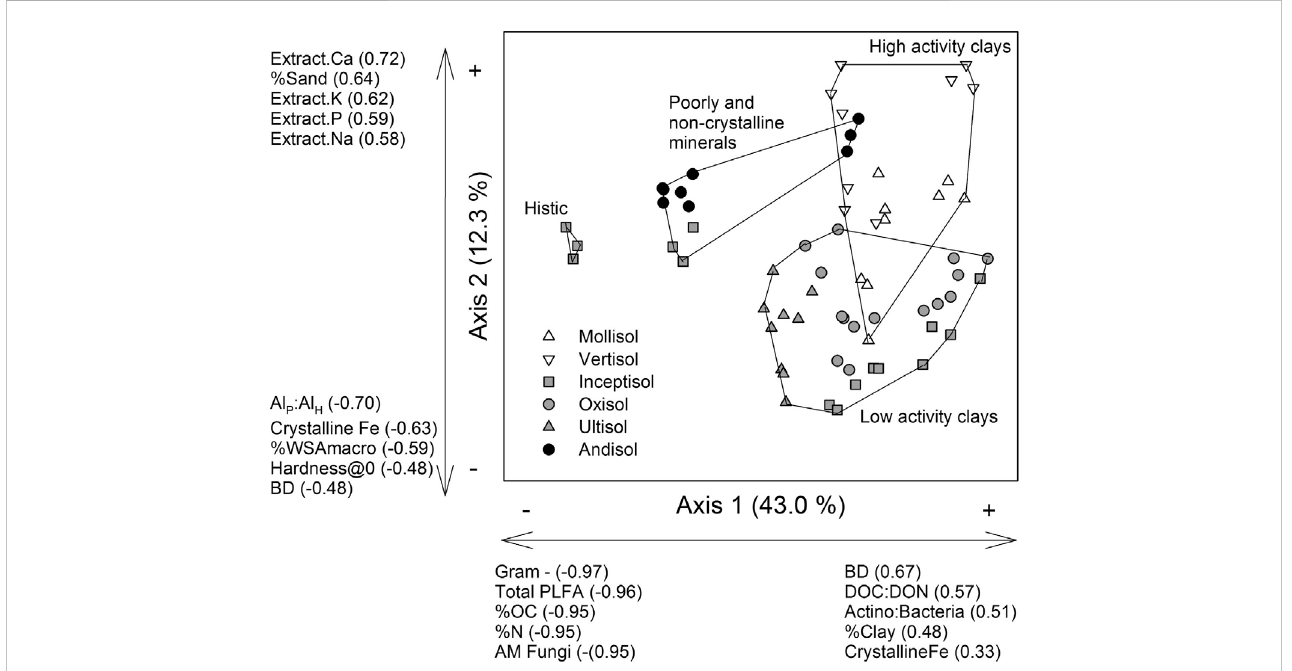
FIGURE 3 Principalcomponentsanalysisofallpotentialsoilhealthindicatorswiththetop fi vemostnegativelyandpositivelycorrelatedvariablestoaxis1andaxis2. Correlation valuesfor each parameter to the axis follow it inparentheses. Groupsare delineated based on broad mineralogical categorization at that site. The soil order of each site is indicated as Mollisol (white triangle), Vertisol (upside down white triangle), Inceptisol (grey square), Oxisol (grey circle), Ultisol (grey triangle), and Andisol (black circle). The amount of variability explained by each axis is in parentheses.